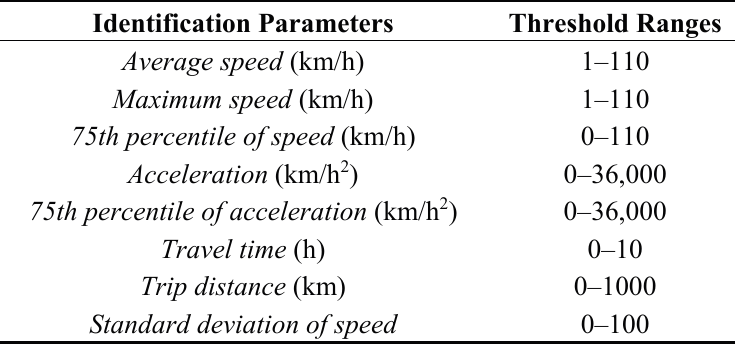
Table 1. The thresholds of identification parameters.